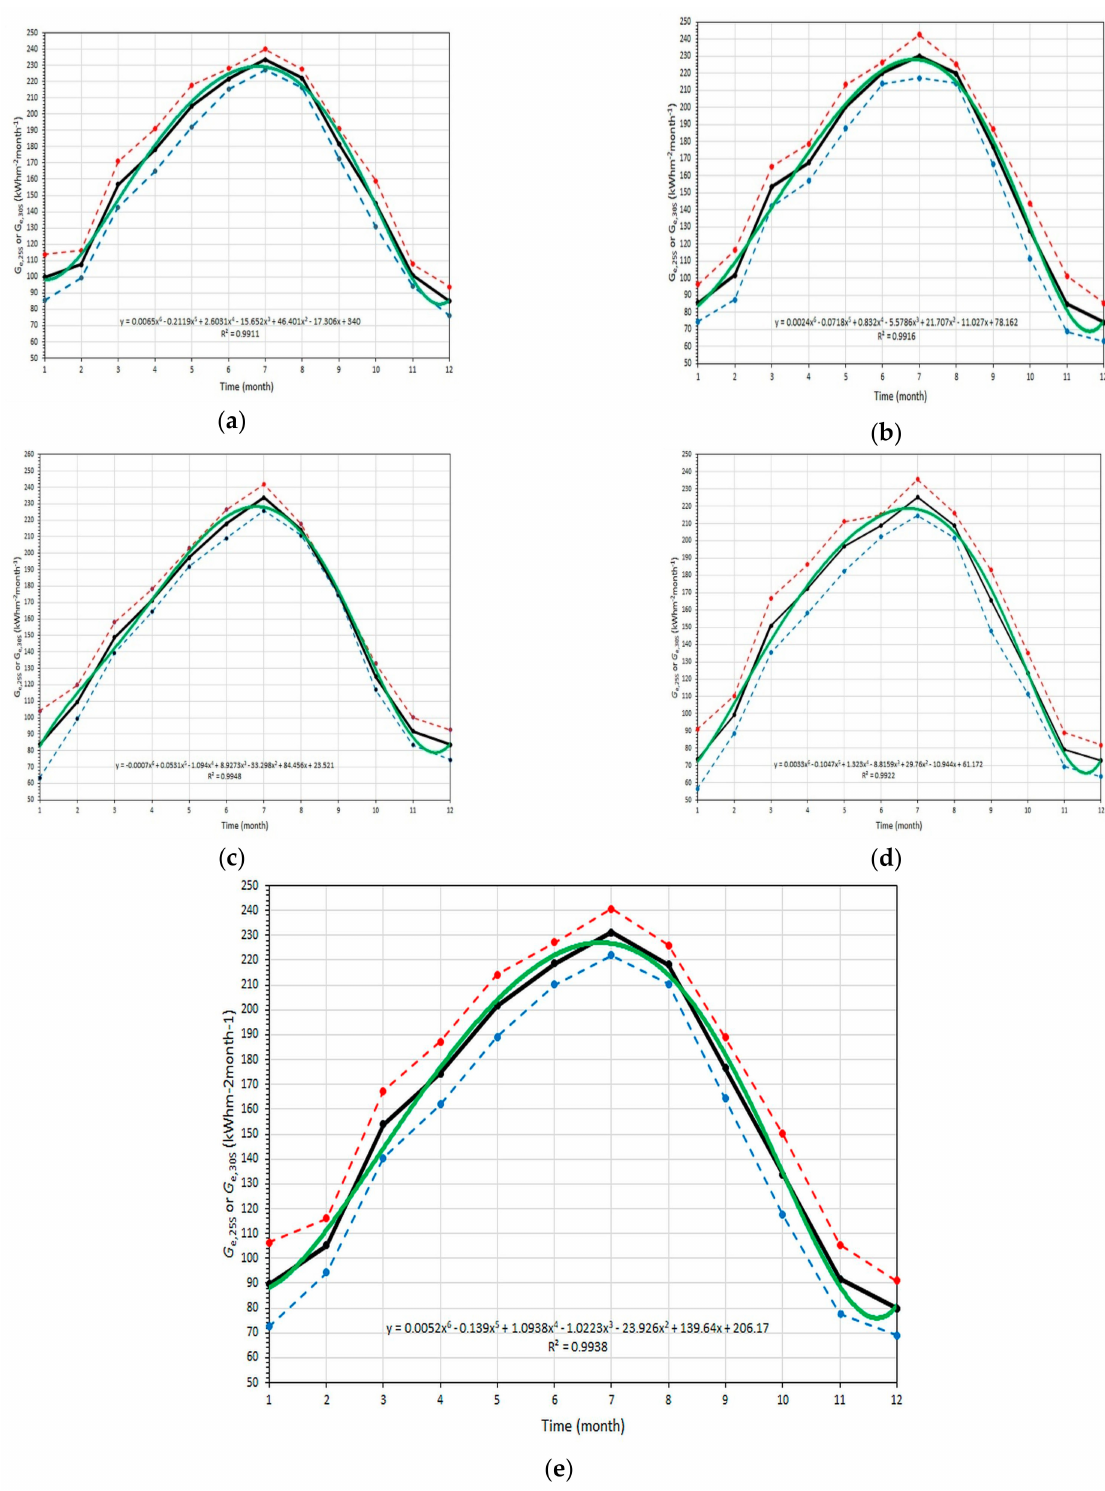
Figure 7. Intra-annual variation of the G e, 25 S or G e ,30 S sums for all sites in PV ctts zone A ( a ), PV ctts zone B ( b ), PV ctts zone C ( c ), PV ctts zone D ( d ), and all PV ctts zones ( e ). The black solid curve represents the average monthly G e values in every PV ctts zone or all PV ctts zones, while the green solid line shows the best-fit curve to the mean G e values. The dashed lines correspond to +1 σ (red curve) and − 1 σ (blue curve). The best-fit equations are functions of y = G e, 25 S or G e ,30 S in terms of x = month of the year (1, . . . , 12). R 2 is also